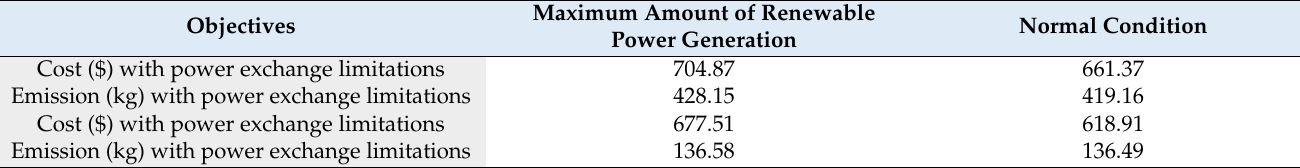
Table 15. Comparison of normal operation and operation with maximum amount of generation of renewable resources. Maximum Amount of Renewable Objectives Normal Condition Power Generation Cost ($) with power exchange limitations 704.87 661.37 428.15